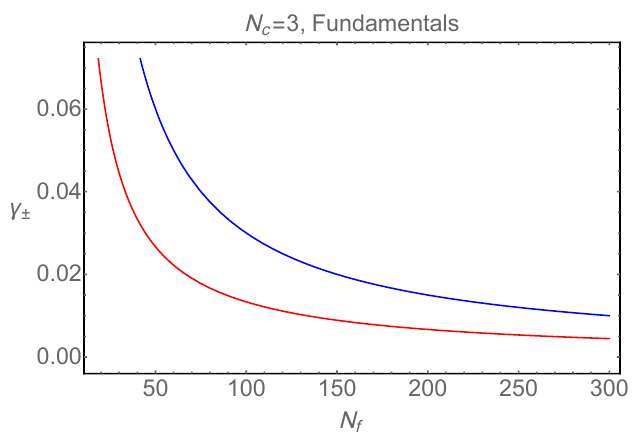
Figure 2 . The anomalous dimension of the spin-1 = 2 baryons at the UV (cid:12)xed point as a function of the number of (cid:13)avors. The upper blue curve is for the choice s (cid:6) = 1 while the lower red curve is for the choice s (cid:6) =